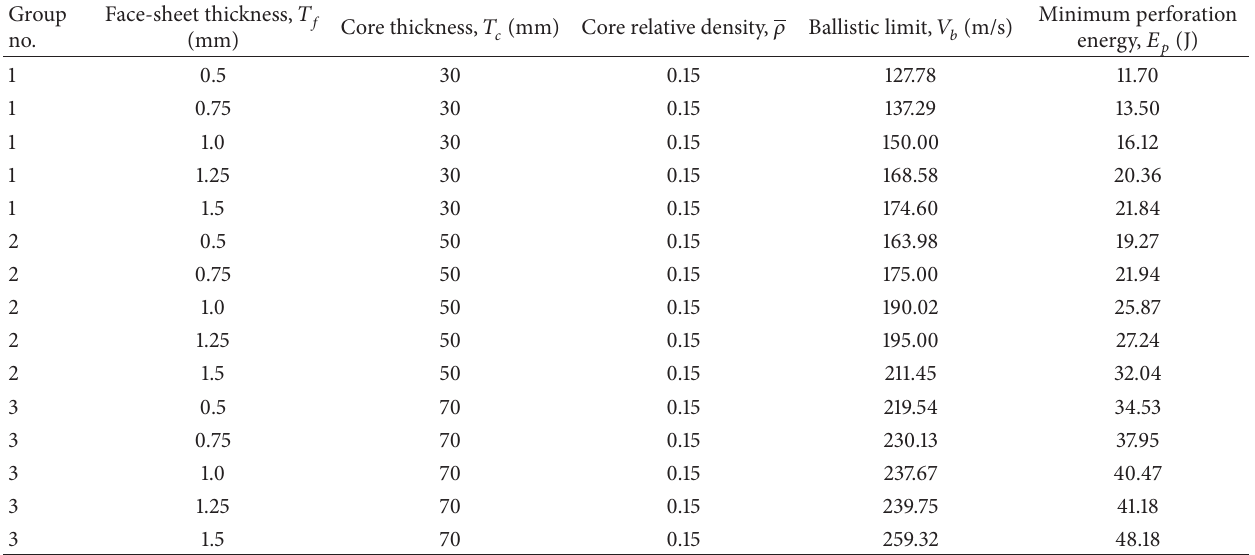
Figure 17: Effects of core relative density on (a) ballistic limit and (b) minimum perforation energy of the auxetic HSPs with three different core thicknesses ( 𝑇 𝑓 = 1.0 mm). Table 2: Specifications and numerical results of three groups of auxetic HSPs, each of which has identical core thickness ( 𝑇 𝑐 = 30 mm, 50mm and 70 mm, respectively) and relative density ( 𝜌 = 0.15 ), but different face thicknesses ( 𝑇 𝑓 = 0.5mm, 0.75 mm, 1.0mm, 1.25mm and 1.5mm, respectively), so that the effect of core and face thickness can be